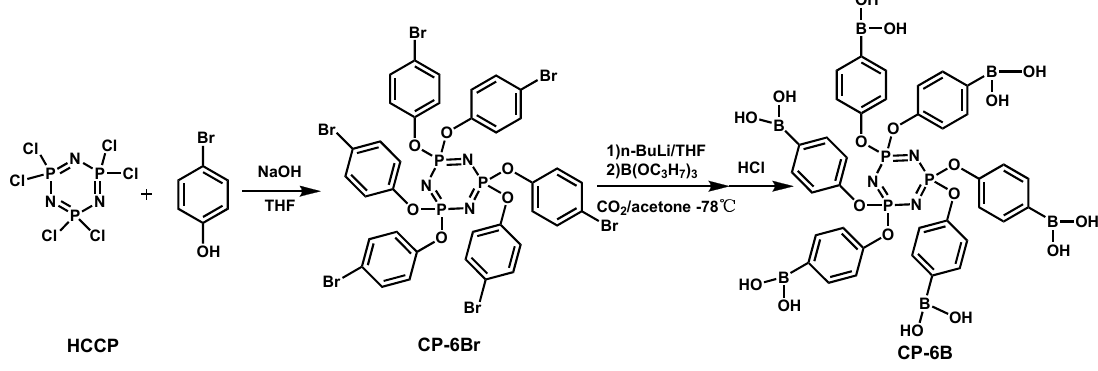
Figure 10. Synthesis route of CP-6B. Readapted with permission from Ref. [99], Copyright 2018 Elsevier